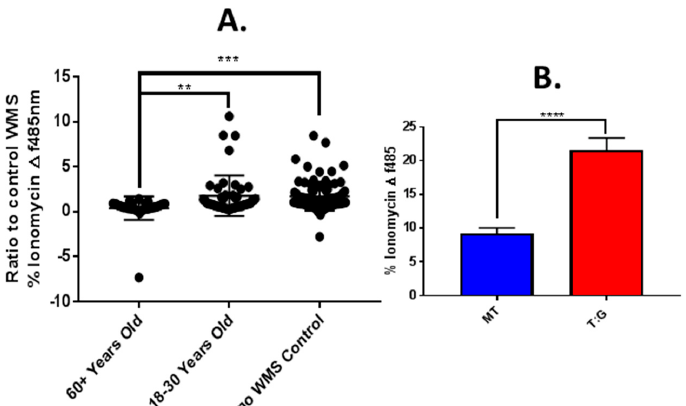
Figure 5. FLEX station measurement of intracellular calcium with PTC in TR146 MUC1 cells with and without UWS from older and younger adults. TR146 MUC1 Cells were loaded with the fluo-4am calcium indicator and incubated with or without UWS from older (60+ years, n = 22) and younger (18–30 years, n = 29) adults. Florescence emissions were recorded using FLEX station fluorescence plate reader, before and after addition of 25µM PTC. A. Mean (+/ ₋ SEM) change ( ∆ ) in fluorescence from baseline after compound addition (normalised to ionomycin response and control WS response), in TAS2R38:Ga16Gust44 co-transfected TR146 MUC1 cells. Cells stimulated with 25µM PTC without WS used for comparison ( n = 44). Data is representative of two experiments. B. Transfection efficiency of TR146 MUC1 cells, without whole mouth saliva (WS). Mean (+/ ₋ SEM) change ( ∆ ) in fluorescence from baseline after compound addition, in mock transfected (MT) and TAS2R38:Ga16Gust44 co-transfected (T:G) TR146 MUC1 cells ( n = 20). Analysed for statistical significance using independent student’s t